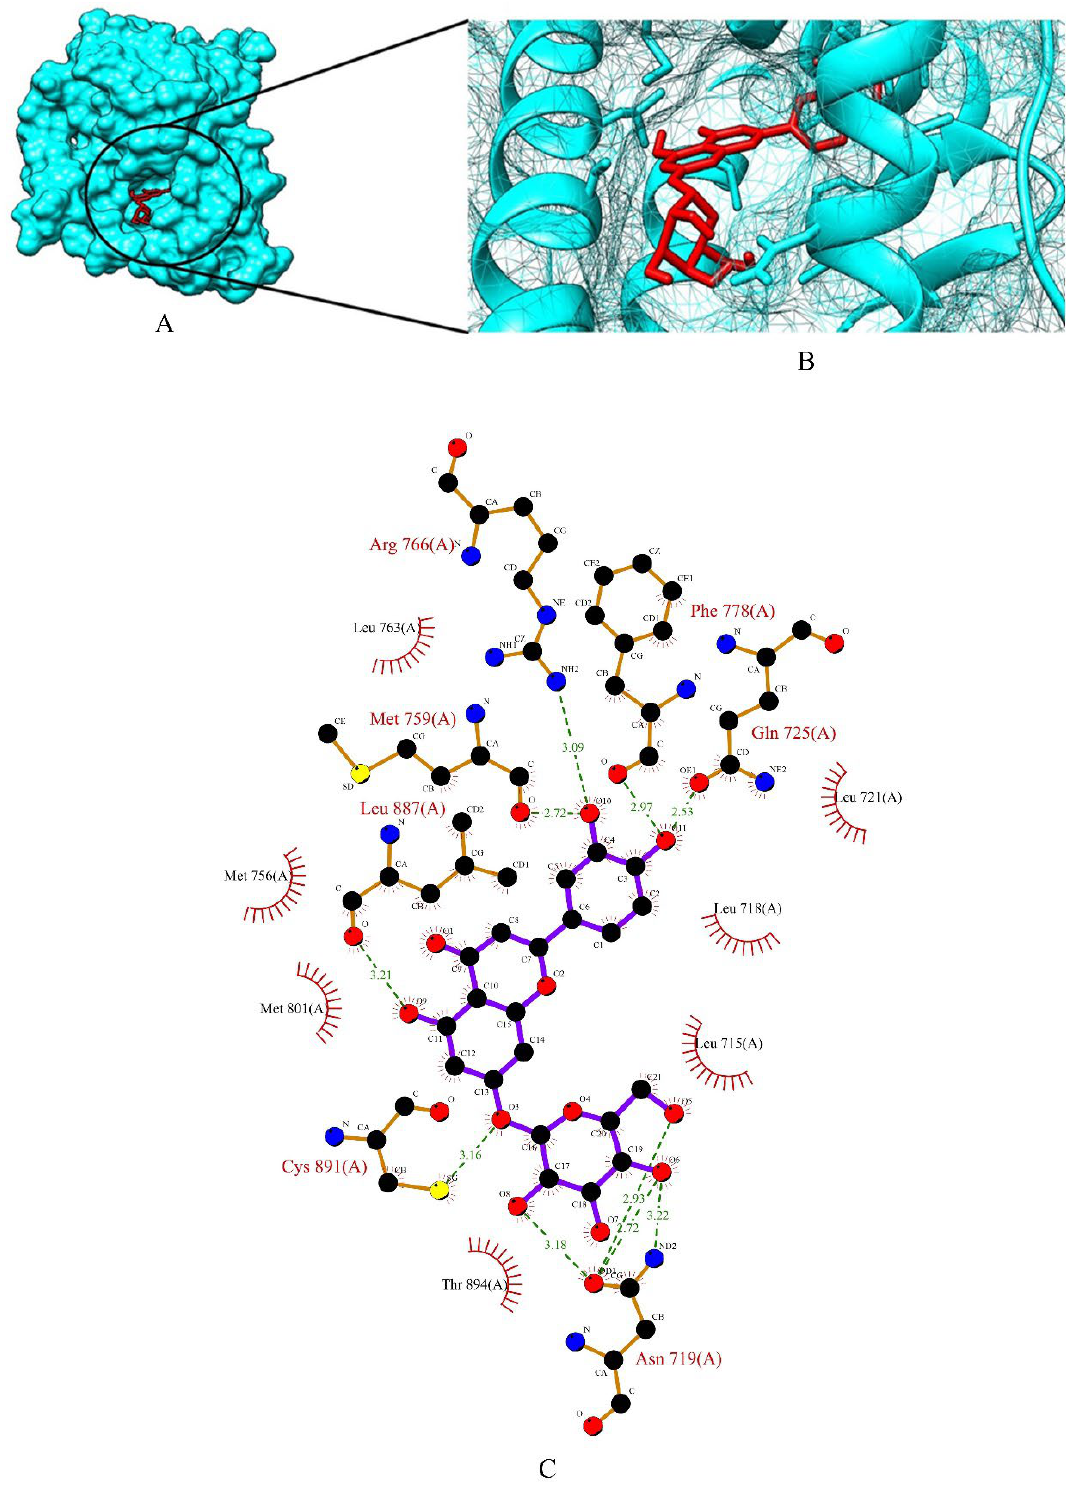
Figure 7. ( A ) Surface view of cynaroside-PR binding complex. ( B ) Binding pose of cynaroside. ( C ) Visualization of the docked complex with ligplot + shows the binding interaction of cynaroside with PR. Ten hydrogen bond interactions (green dotted lines) were formed between cynaroside and seven amino acid residues (Asn 719, Gln 725, Met 759, Arg 766, Phe 778, Leu 887, Cys 891) of target protein PR.